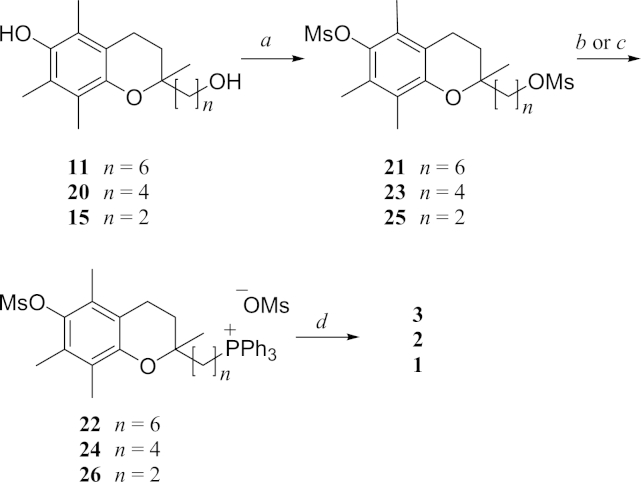
Syntheses of MitoE2, MitoE4 and MitoE6. Reagents and conditions: a MsCl, Et3N, CH2Cl2; b PPh3, 80 C (21 and 23); c PPh3, NaI, 90 C (25); d LDA, THF.